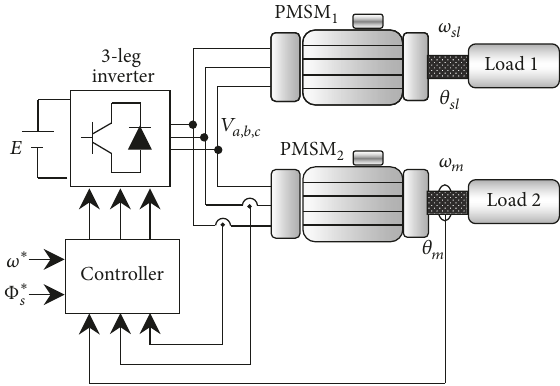
Figure 4: Master choice